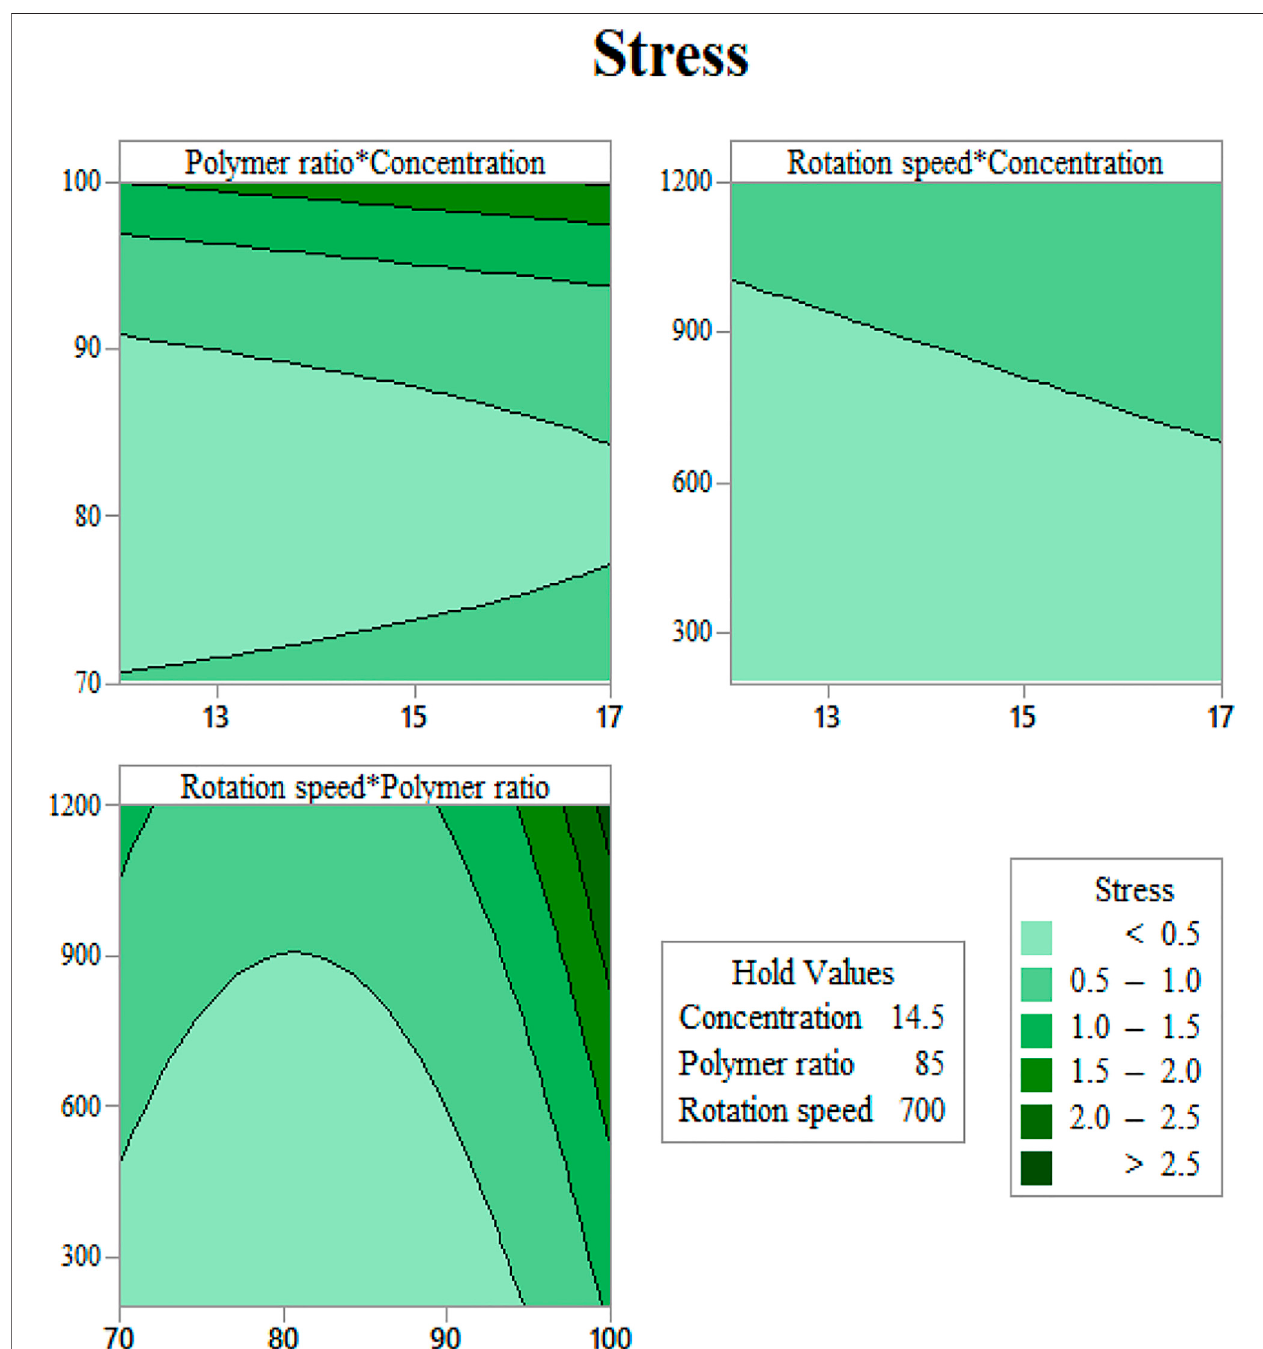
FIGURE 6 | Yield stress contours as functions of input variables: (A) gelation content vs. concentration, (B) mandrel rotation speed vs. concentration, and (C) mandrel rotation speed vs. gelatin content.